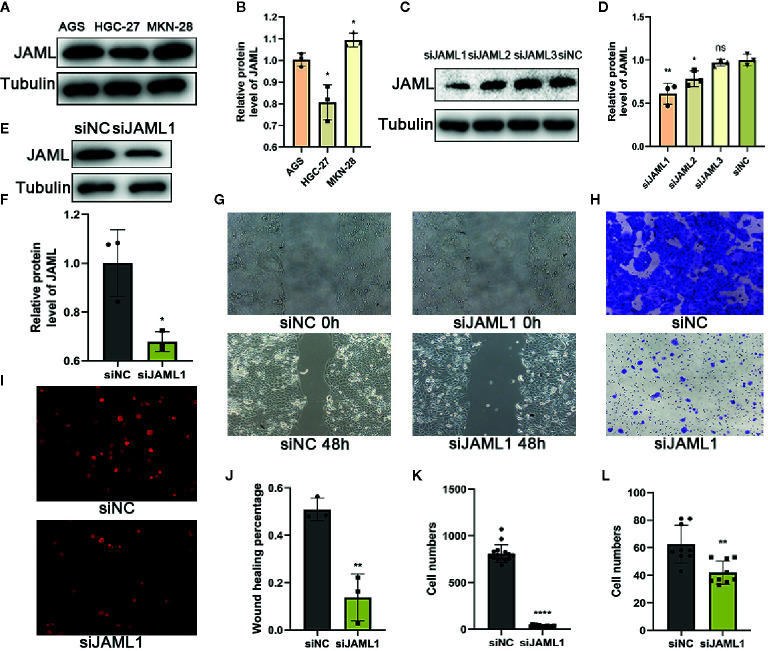
JAML promoted GC cell proliferation and migration. (A) The expression of JAML in GC cell lines (AGS, HGC-27, MKN-28). (B) Quantitative analysis of (A) n=3, unpaired t test, *P < 0.05, compared with AGS group. (C) Knockdown efficiency of JAML was confirmed in MKN-28 cells after transient transfection of SiRNA for 72h by western blot. (D) Quantitative analysis of (C) n=3, unpaired t test, **P < 0.01, compared with siNC group; n=3, unpaired t test, *P < 0.05, compared with siNC group; n=3, unpaired t test, ns, P>0.05, compared with siNC group. (E) Knockdown efficiency of JAML in MKN-28 cells after transient transfection of siRNA for 120h by western blot. (F) Quantitative analysis of (E) n=3, unpaired t test, *P < 0.05, compared with siNC group. (G) Wound healing assay was performed in transfected MKN-28 cells treated with or without siRNA to evaluate cell migration. (H) Transwell migration assay to assess cell migration. (I) EdU incorporation assay to observe cell proliferation. (J) Quantitative analysis of (G) n=3, unpaired t test, **P < 0.01, compared with siNC group. (K) Quantitative analysis of (H) n=15, unpaired t test, ****P < 0.0001, compared with siNC group. (L) Quantitative analysis of (I) n=9, unpaired t test, **P < 0.01, compared with siNC group. siNC, negative control.